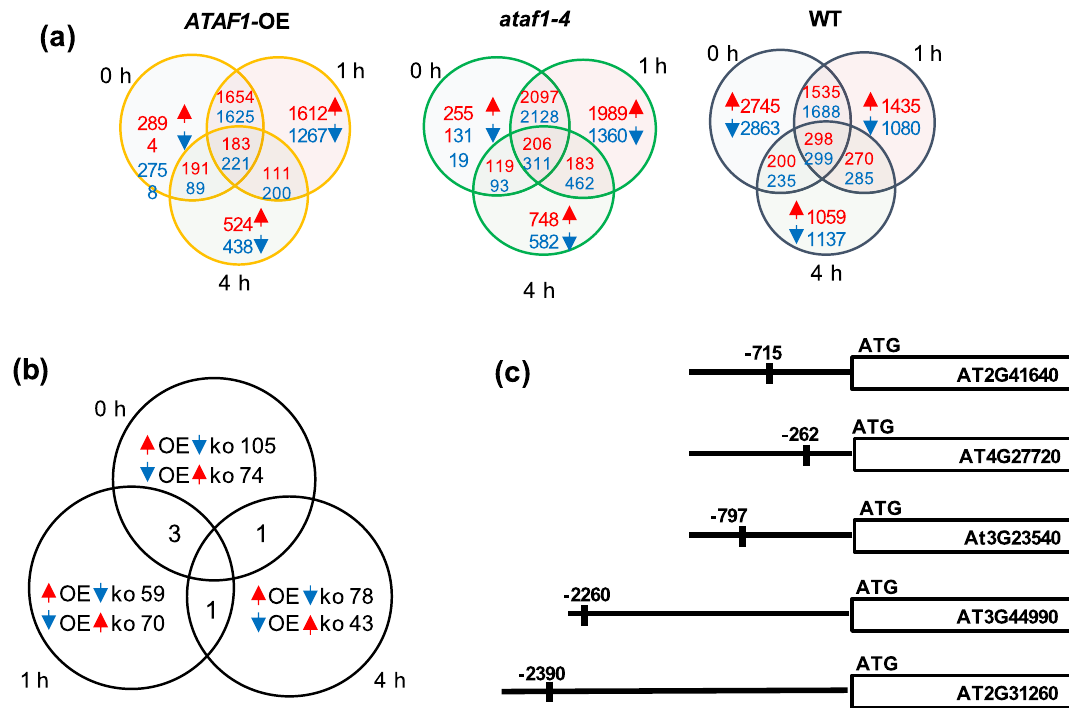
Figure 5. Global transcriptomic changes of thermomemory-associated genes potentially regulated by ATAF1. ( a ) Venn diagrams of heat-induced and heat-repressed genes, after heat priming (heat relative to control) in WT, ataf1–4 mutant, and ATAF1 -OE transgenic plants. ( b ) Venn diagram of genes upregulated in ATAF1 -OE and downregulated in ataf1 mutant, and vice versa, compared to WT, in response to a priming HS, after 0 h, 1 h or 4 h. ( c ) Schematic representation of the position of ATAF1-binding sites in the upstream regions of genes identified in ( b